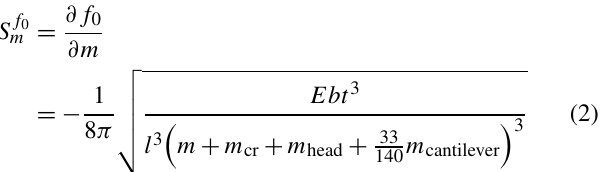
Figure 3. Boundary conditions for finite element modeling of the DSC chip (a) and eigenfrequency study (b)